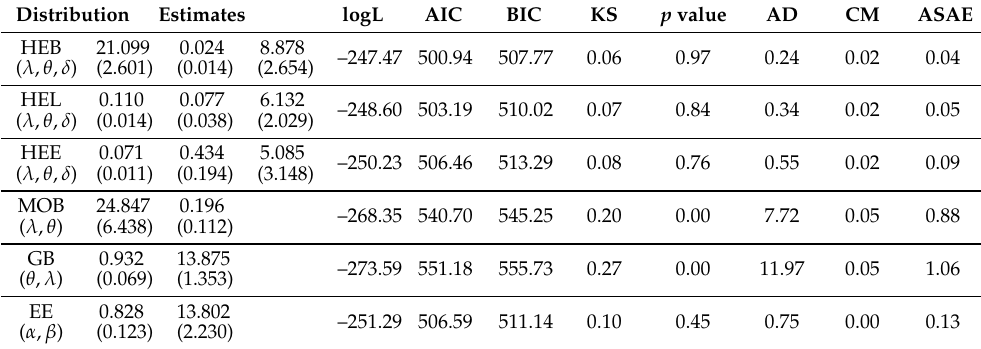
Table 2. ML estimates with SEs (in parentheses), information criteria, and goodness-of-fit-measures of the models for the Wheaton river